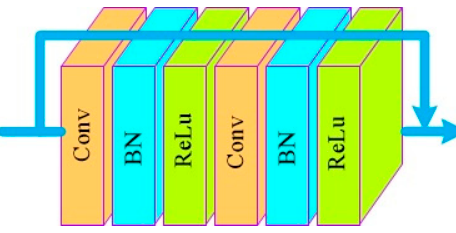
Figure 6. The model of convolutional module.